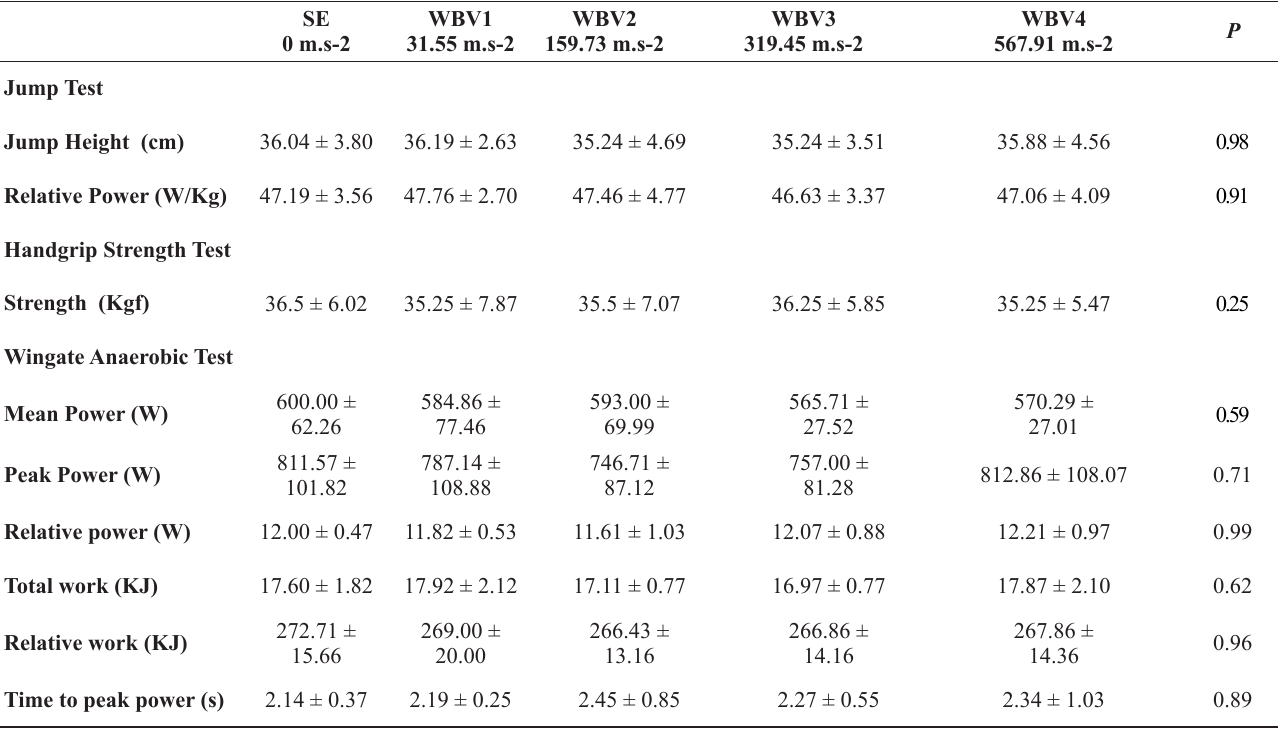
Table 1 - Baseline data (pretest) of muscular performance for the experimental conditions (N=9).